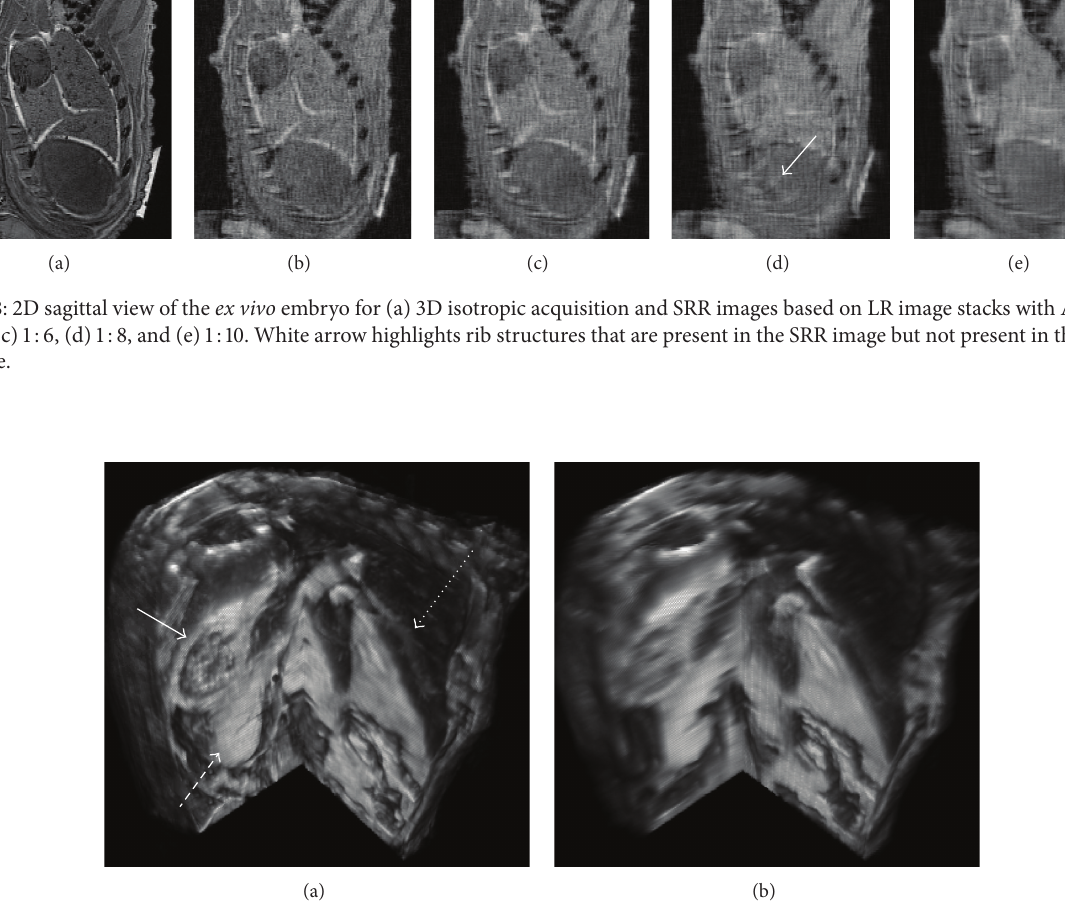
Figure 9: Cutaway section from 3D volume rendering of the in vivo mouse abdomen based on orthogonal SRR (a) with AR equal to 1:1:10 and single interpolated view (b). The solid arrow points to the wall of the stomach, dashed arrow to the kidney, and dotted arrow to the liver vasculature. Biological structures can be observed clearly in any oblique cutting plane of the SRR image as opposed to single 2D multislice image with linear